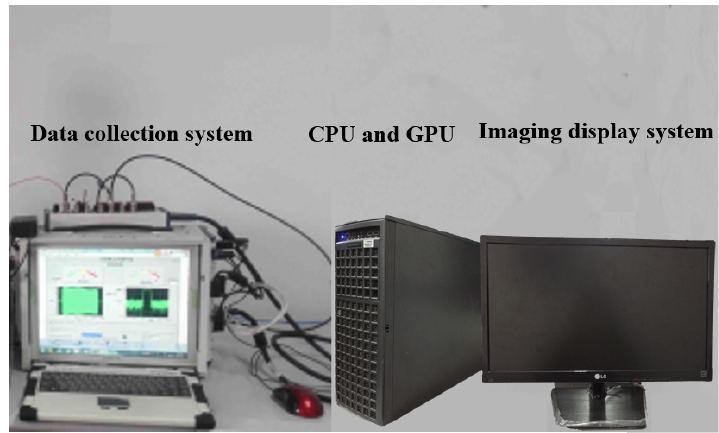
Figure 10. The RBM system and the GPU server platform.